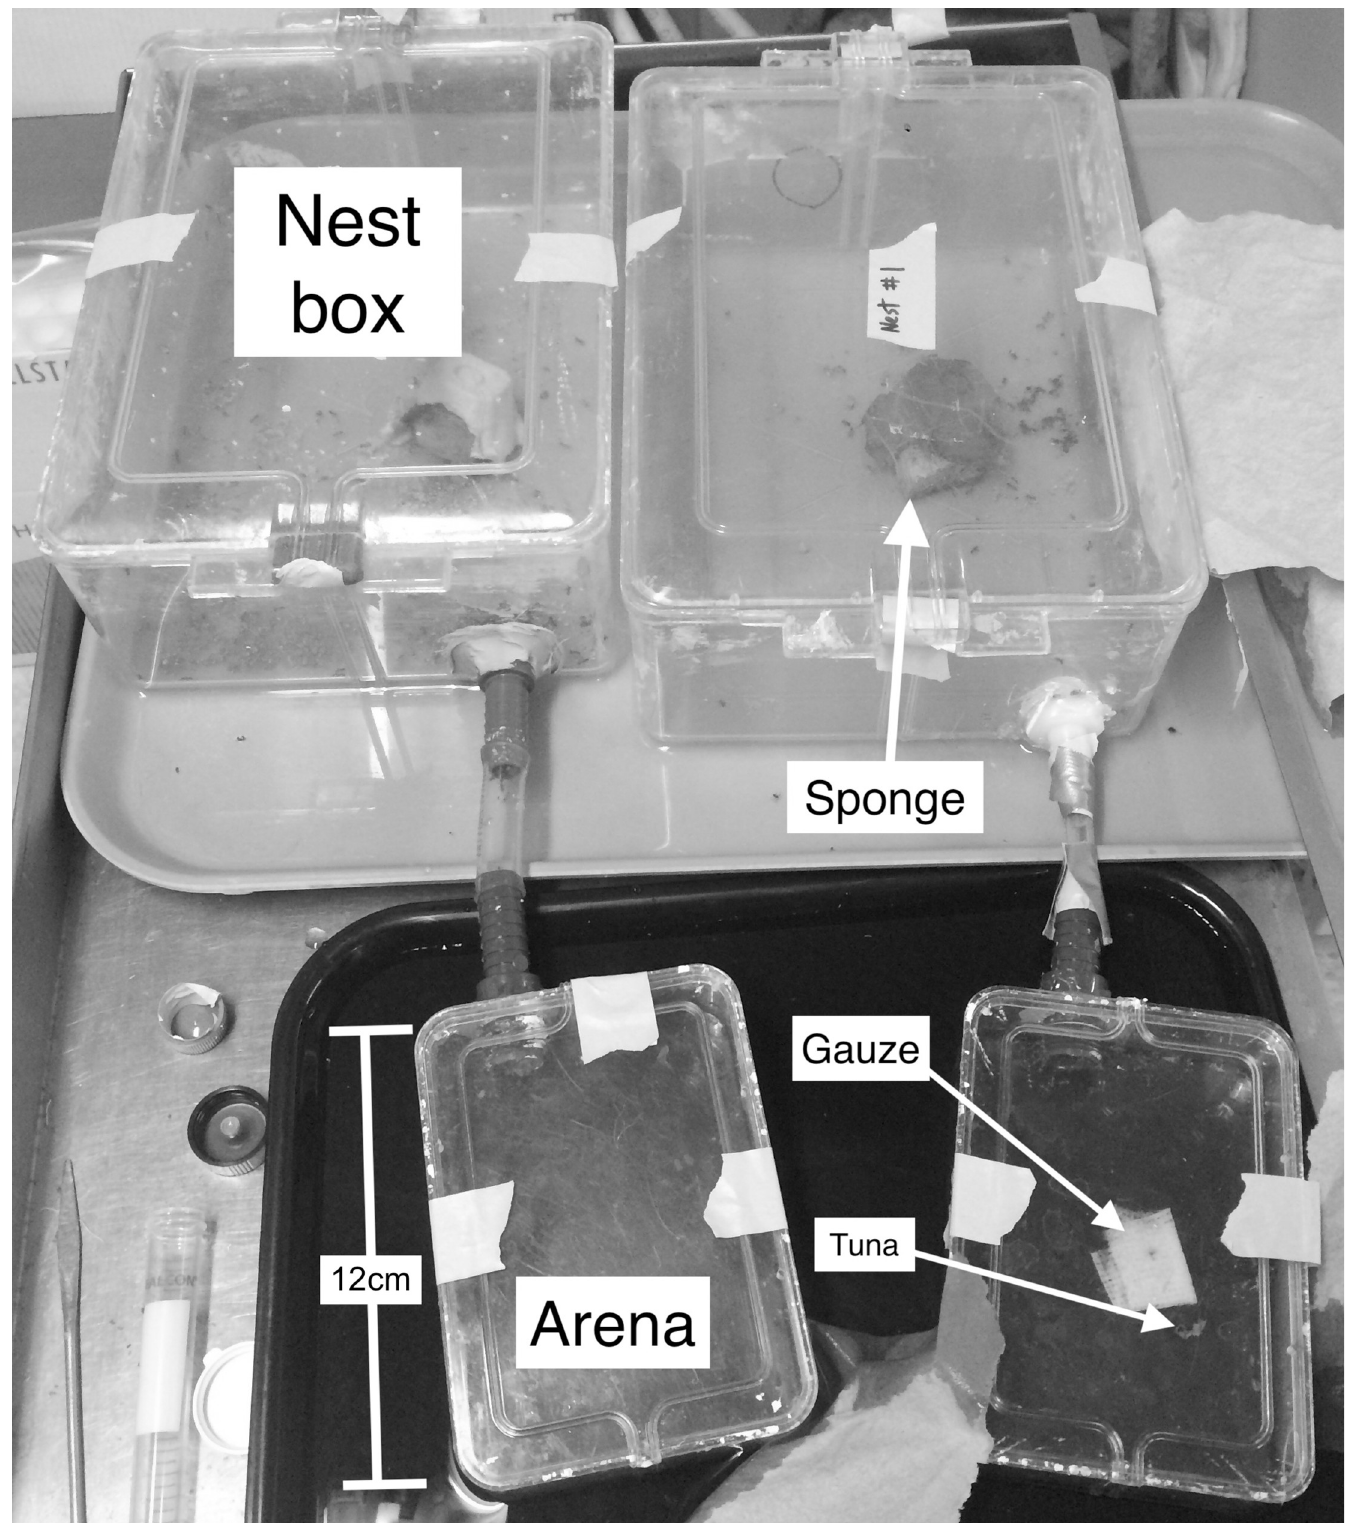
Fig 2. Ant nest boxes with connected arenas used to conduct aggression bioassays. Ant nests were maintained in nest boxes and Myrmica rubra were allowed to interact with Ixodes scapularis larvae, nymphs, and adults and Dermacentor variabilis adults.